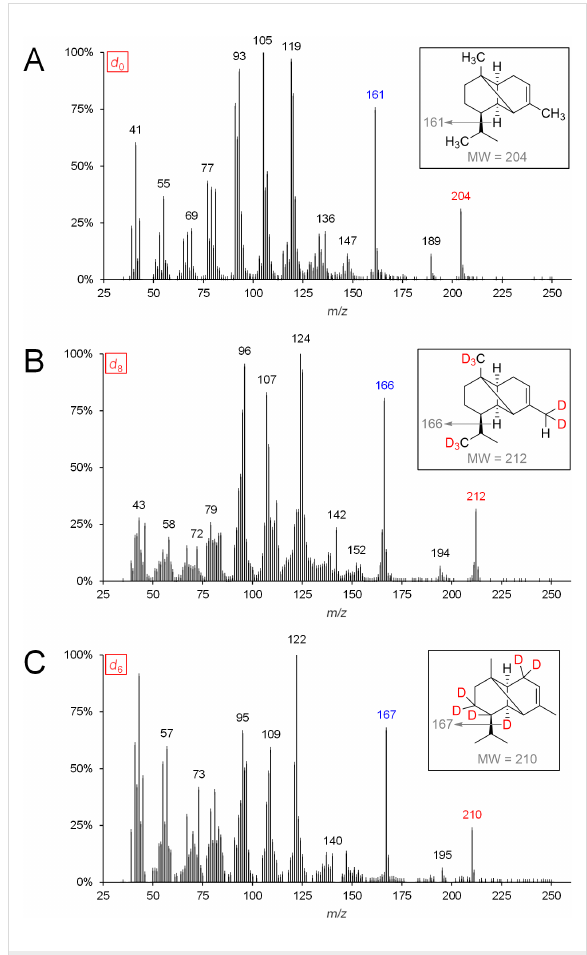
Figure 5: MS spectra and expected labeling patterns of A: d 0 - α -ylan- gene, B: d 8 - α -ylangene after administration of d 3 -MVL to isolated exocarp of grapes and C: d 6 - α -ylangene after feeding experiments using d 2